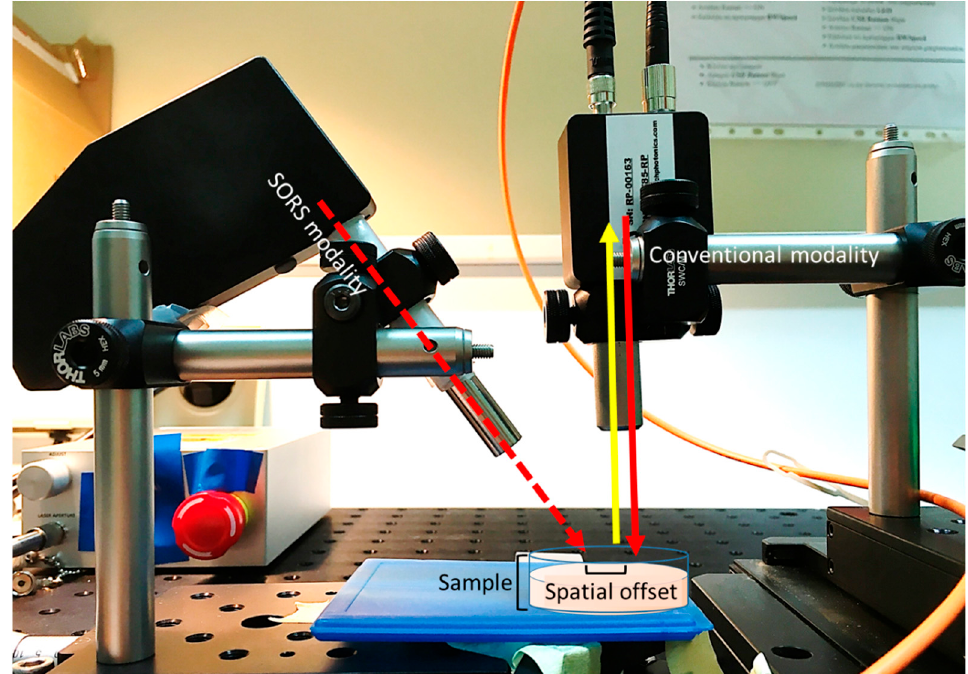
Figure 2. Raman setup in a conventional (excitation indicated with red solid line) and a SORS (excitation with red dashed line) configuration. In the SORS configuration, a 785 nm laser was delivered at a 45° angle with regards to the collection path. A translational xyz stage was used to move the collection away from the external excitation path.